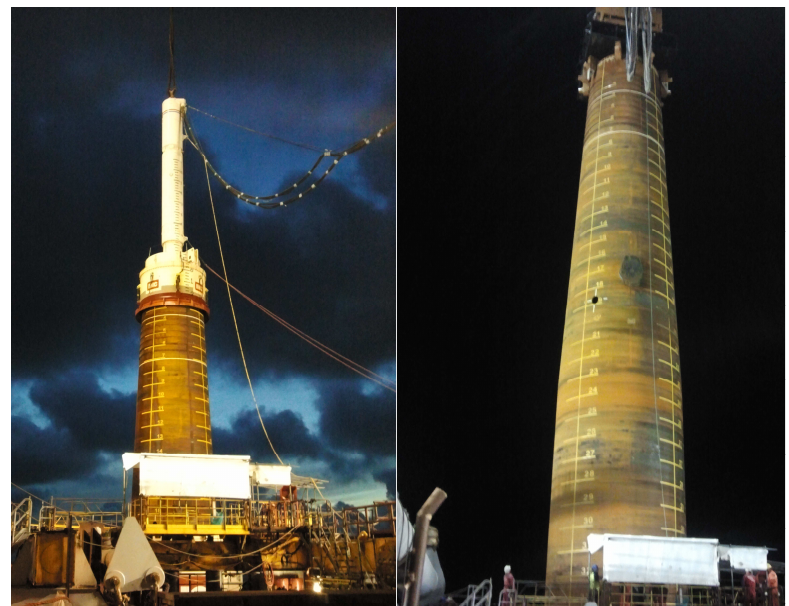
Figure 1. Installation of a pile with an impact hammer ( left ) and with a vibratory device ( right ) [19]. Source: Author’s personal archive from the Riffgat Offshore Wind Farm